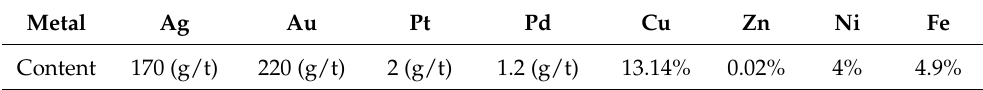
Table 1. Chemical composition of printed circuit boards.